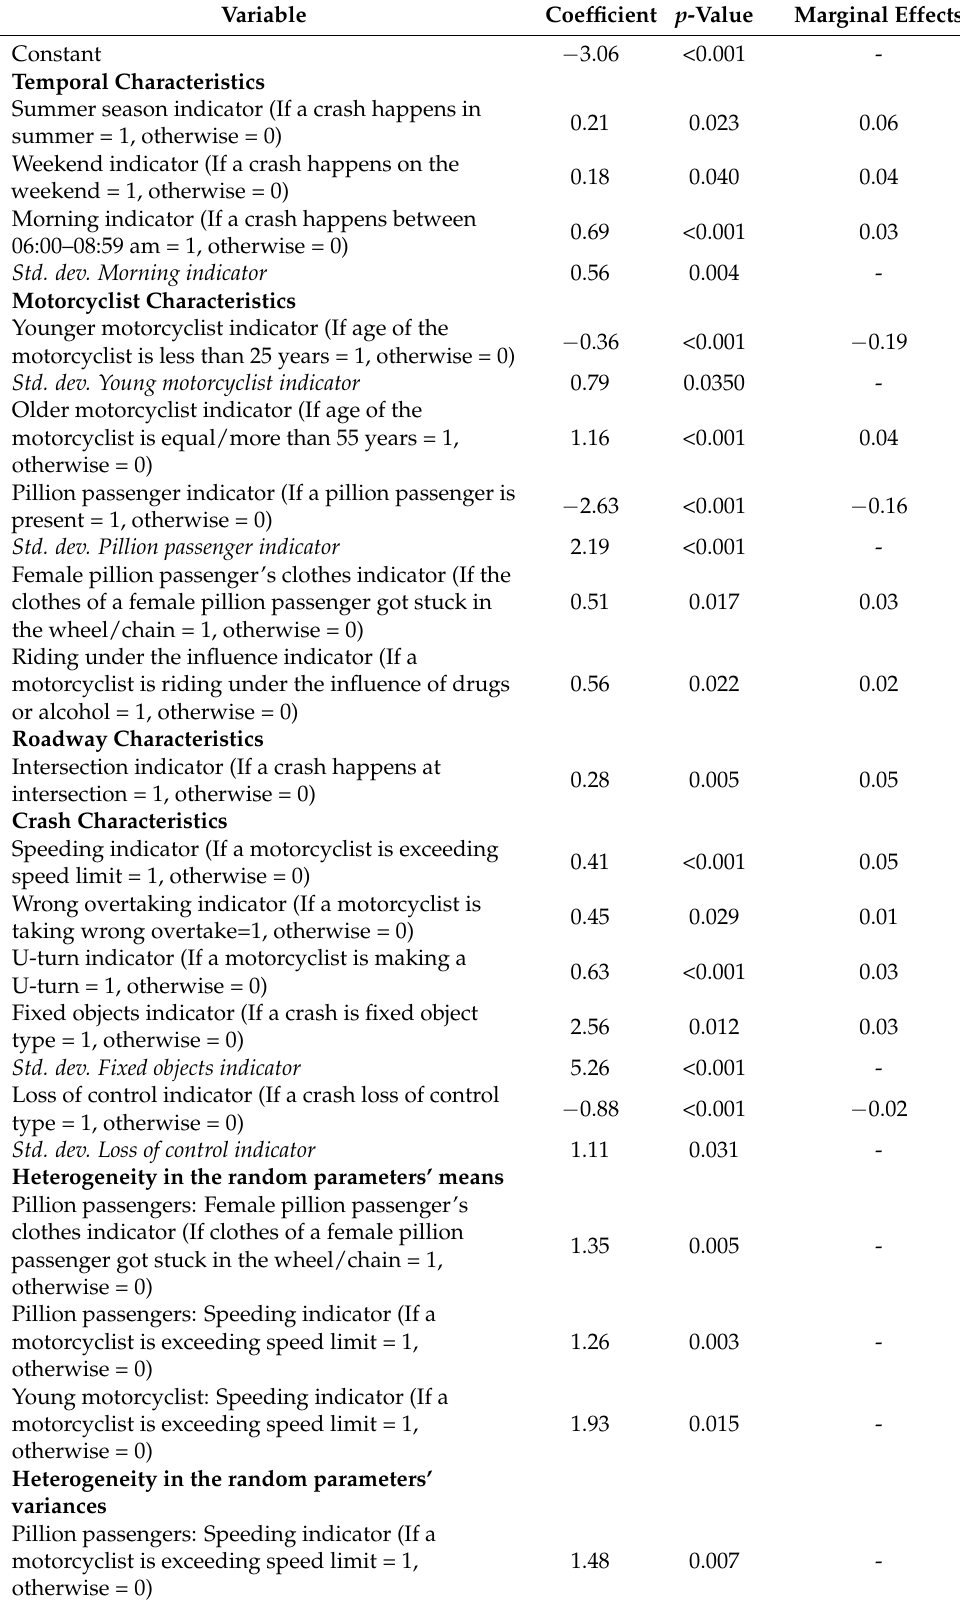
Table 3. Estimated model